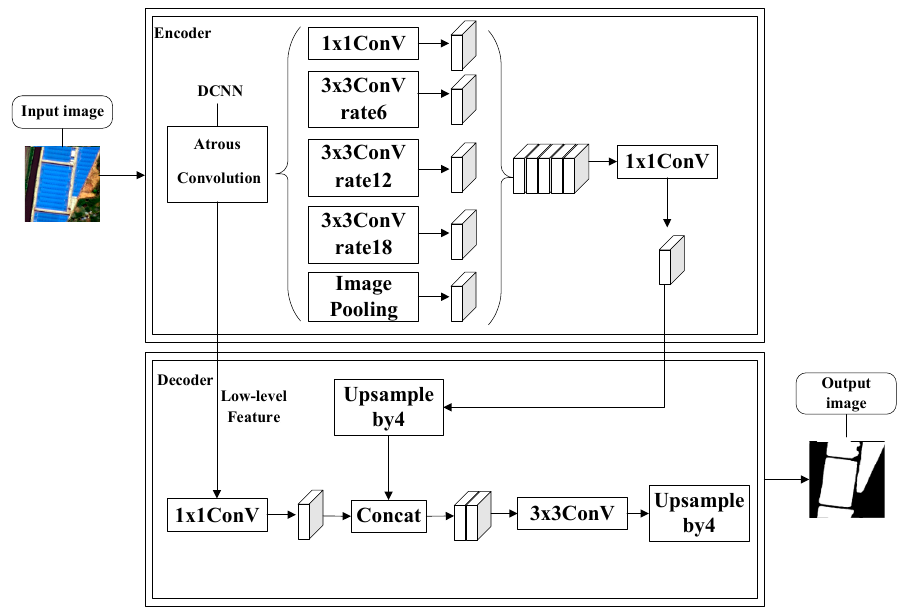
Figure 2. DeepLabV3+ semantic segmentation model [28].